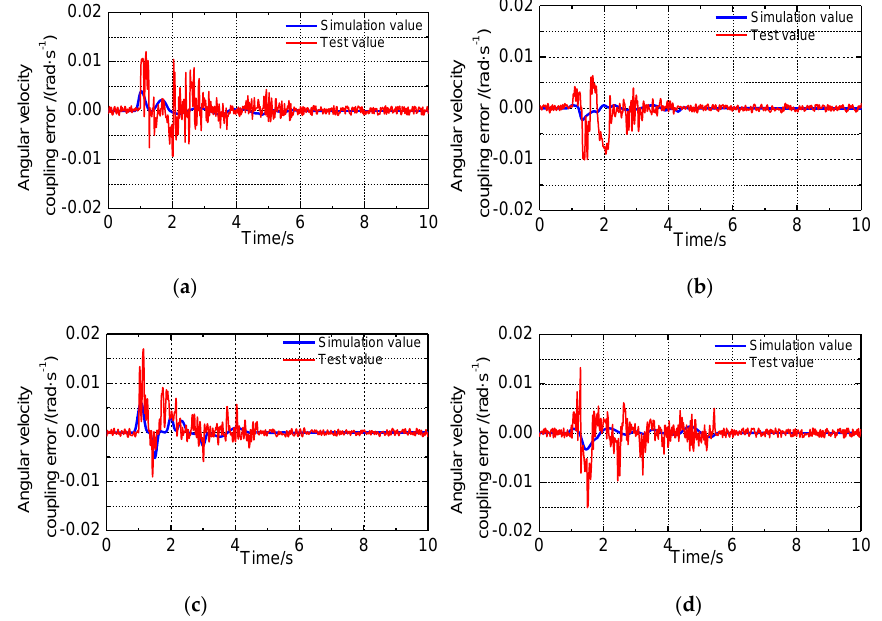
Figure 16. Angular velocity coupling errors of motion mode switching: ( a ) cross motion; ( b ) in-place rotation; ( c ) diagonal motion; ( d ) steering motion. Table 3. Longitudinal and lateral acceleration of the flexible chassis centroid.